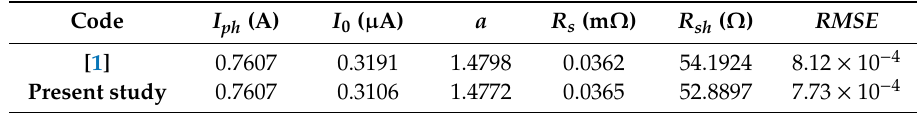
Figure 5. Comparison between experimental data (green dots) and calculated I-V curve (blue line) for the R.T.C France solar cell. Table 2. Parameter extraction results of the R.T.C France commercial silicon solar cell with those reported in [1].